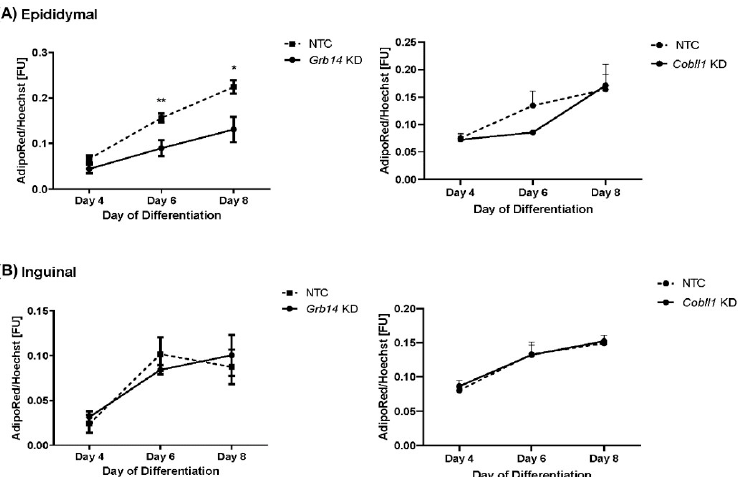
Figure 8. Quantification of lipid droplets by measuring the AdipoRedTM fluorescence signal nor- malized to the Hoechst fluorescence signal. Lipid droplets quantification ( A ) in the epididymal cell line and ( B ) in the inguinal cell line. Lipid accumulation normalized to the Hoechst signal compared to NTC (non-silencing siRNA group). AdipoRed stains the triglycerides of the lipid droplets and Hoechst stains the nuclei of cells. KD: knock-down. * p < 0.05, ** p <